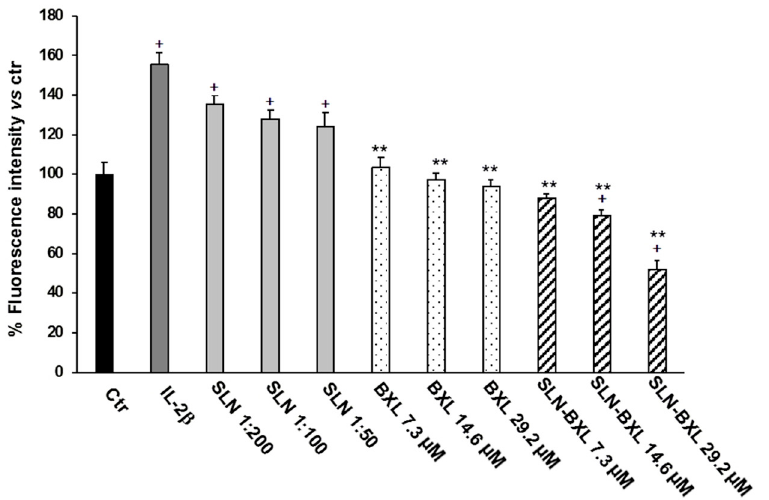
Figure 6. ROS levels in HFF-1 cells untreated (Ctr), treated with IL-2 β (3 µ M), and pre-treated with SLN, BXL, and SLN-BXL at different concentrations. Values are expressed as mean ± S.D. of four experiments in triplicate. + Significant vs. untreated control cells p < 0.001; ** significant vs. IL-2 β -treated cells: p < 0.001.